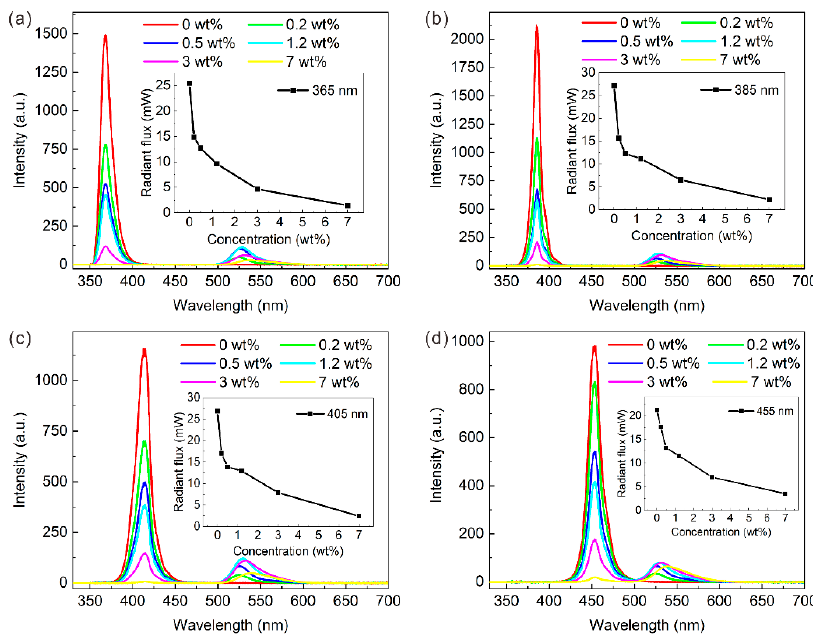
Figure 6. Electroluminescence (EL) spectrum of GQD LED with ( a ) 365 nm, ( b ) 385 nm, ( c ) 405 nm, and ( d ) 455 nm of LED-chip excitation wavelength under 20 mA. Inset graph shows radiation flux vs. GQD concentration.